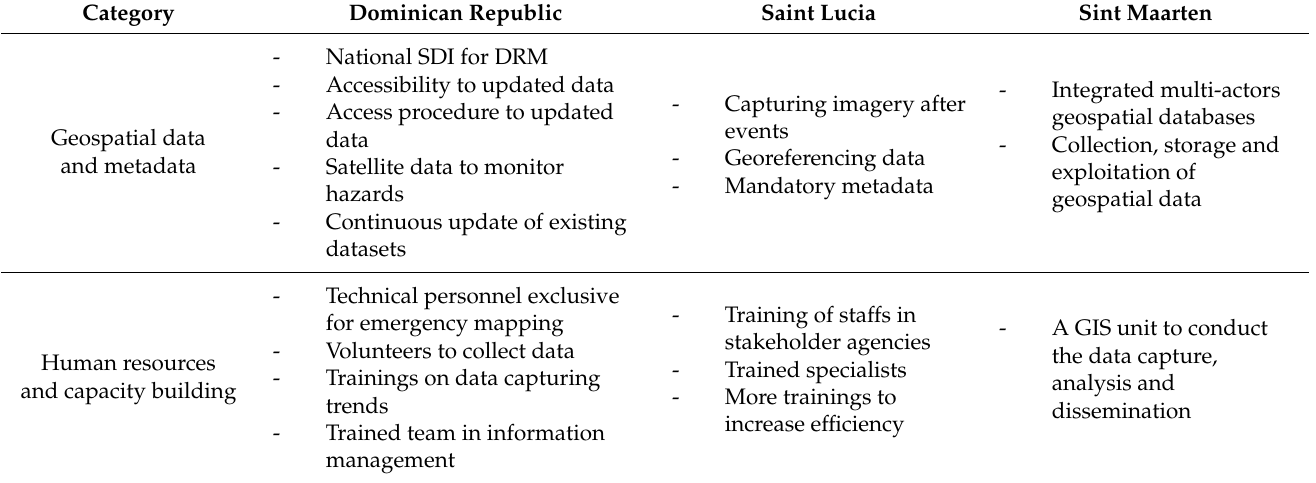
Table A2. Recommendations for EMT data generation